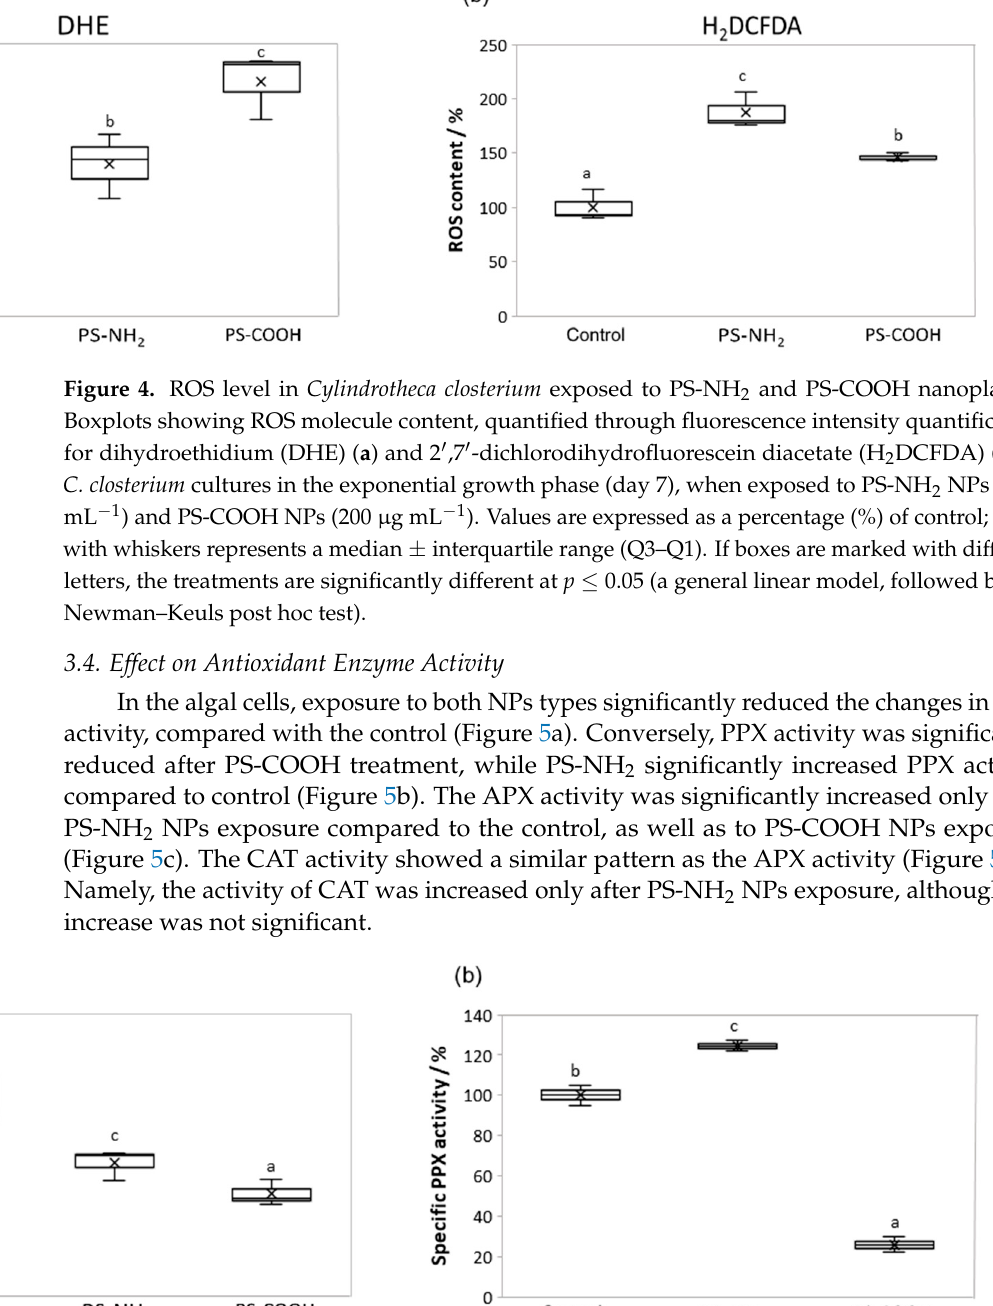
Figure 5. Antioxidant enzyme activities of Cylindrotheca closterium exposed to PS-NH 2 and PS- COOH nanoplastics. Boxplots showing the differences in specific activity of superoxide dismutase (SOD) ( a ), pyrogallol peroxidase (PPX) ( b ), ascorbate peroxidase (APX) ( c ), and catalase (CAT) ( d ) in C. closterium cultures in the exponential growth phase (day 7), when exposed to PS-NH 2 NPs (5 µg mL − 1 ) and PS-COOH NPs (200 µg mL − 1 ). Values are expressed as a percentage of control; a box with whiskers represents a median ± interquartile range (Q3–Q1). If boxes are marked with different letters, the treatments are significantly different at p ≤ 0.05 (general linear model, followed by the Newman - Keuls post hoc test). 3.5. Effect on Lipid Perodixation In algal cell cultures, the exposure to both NPs types (5 µg mL − 1 for PS-NH 2 and 200 µg mL − 1 for PS-COOH) for seven days resulted in a significant increase in lipid peroxidation level, compared to the control (Figure 6).